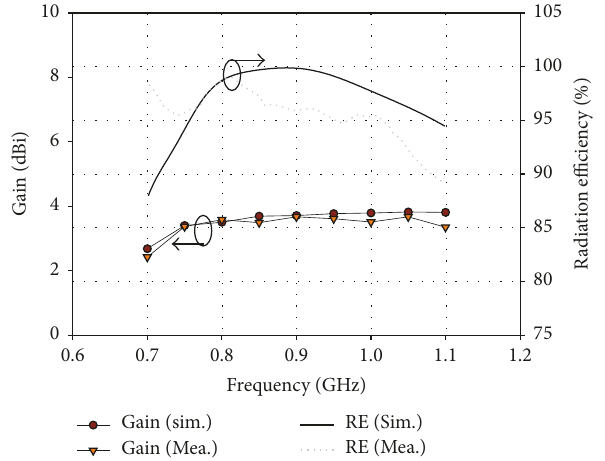
Figure 9: Gain and radiation efficiency results of the manufactured